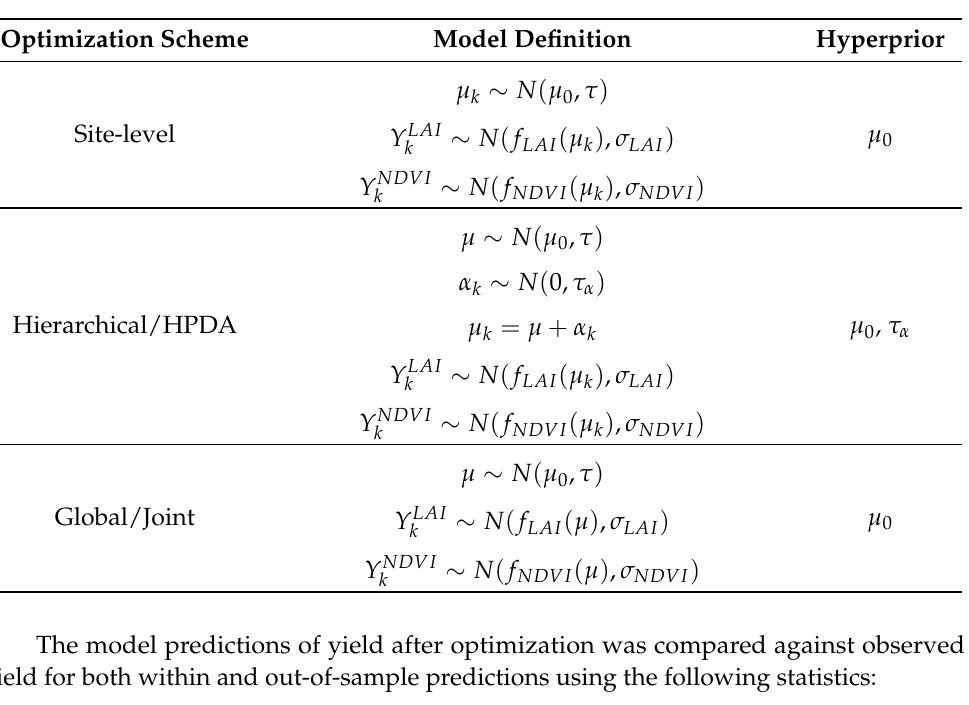
Table 1. Model definition for different optimization schemes explored in this study. Across all schemes, µ represents the vector of model parameters, k represents observations or parameters for site k , Y represents LAI and NDVI observations, and f represents the